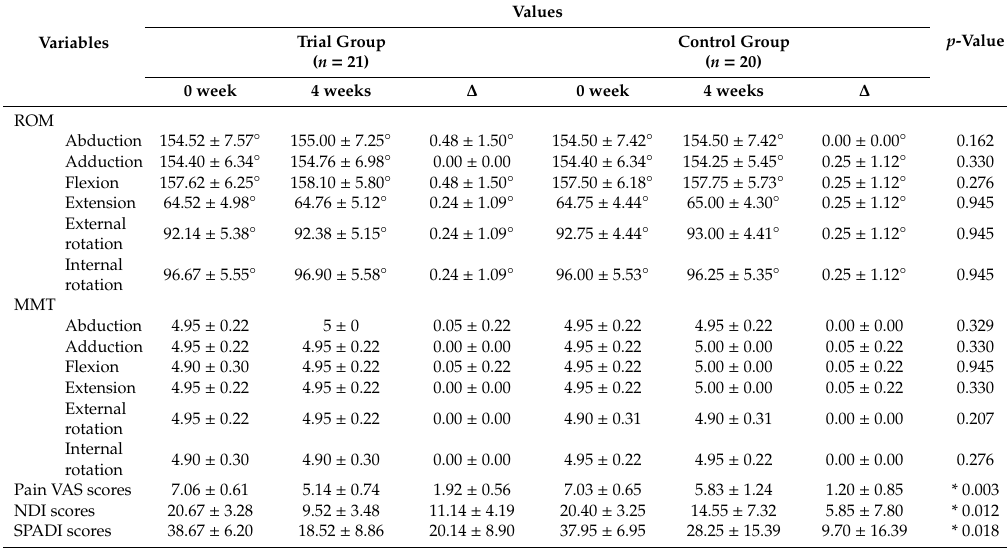
Table 3. E ffi cacy